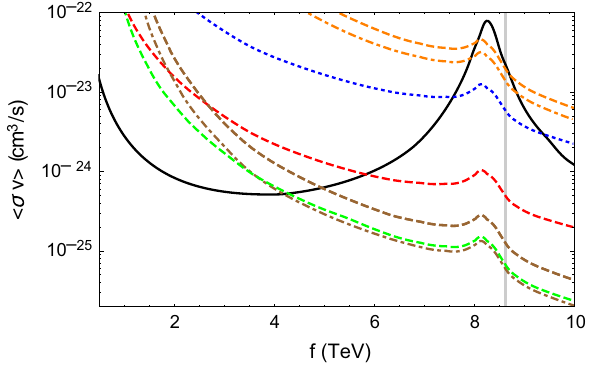
Fig. 4 The thermally averaged annihilation rate of ηη into W + W − as a function of the compositeness scale, f . The black continuous line is the theoretical prediction of the model. From top to bottom we also show the upper bounds (rescaled with the square of the DM abundance) from the following observations: H.E.S.S. dwarf spheroidal galaxies [Burkert ( dashed ) and NFW ( dot-dashed ) profiles, in orange ], CMB from Planck ( blue , dotted ), the combination of FERMI and MAGIC dwarf spheroidal galaxies ( red , dashed ), and the Milky Way center as seen by H.E.S.S. [NFW ( dashed ) and Einasto ( dot-dashed ) profiles, in brown ]. See the main text for references. The green dashed line is the expected sensitivity of CTA for observations of the Milky Way center assuming an Einasto profile [44]. The vertical band at f (cid:19) 8 . 5 TeV locates the scale that gives the total DM abundance with a 95% C.L. from the prediction of the model; see also Fig.